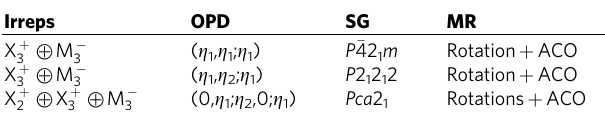
Table 1 | Irreps, OPDs, SGs and mode representation of distorted structures arising from rotational modes ( X þ X þ ) and A-site cation ordering ( M (cid:3) 3